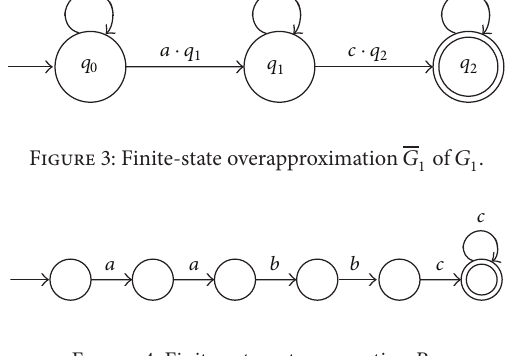
Figure 2: PDA 𝐺 1 .